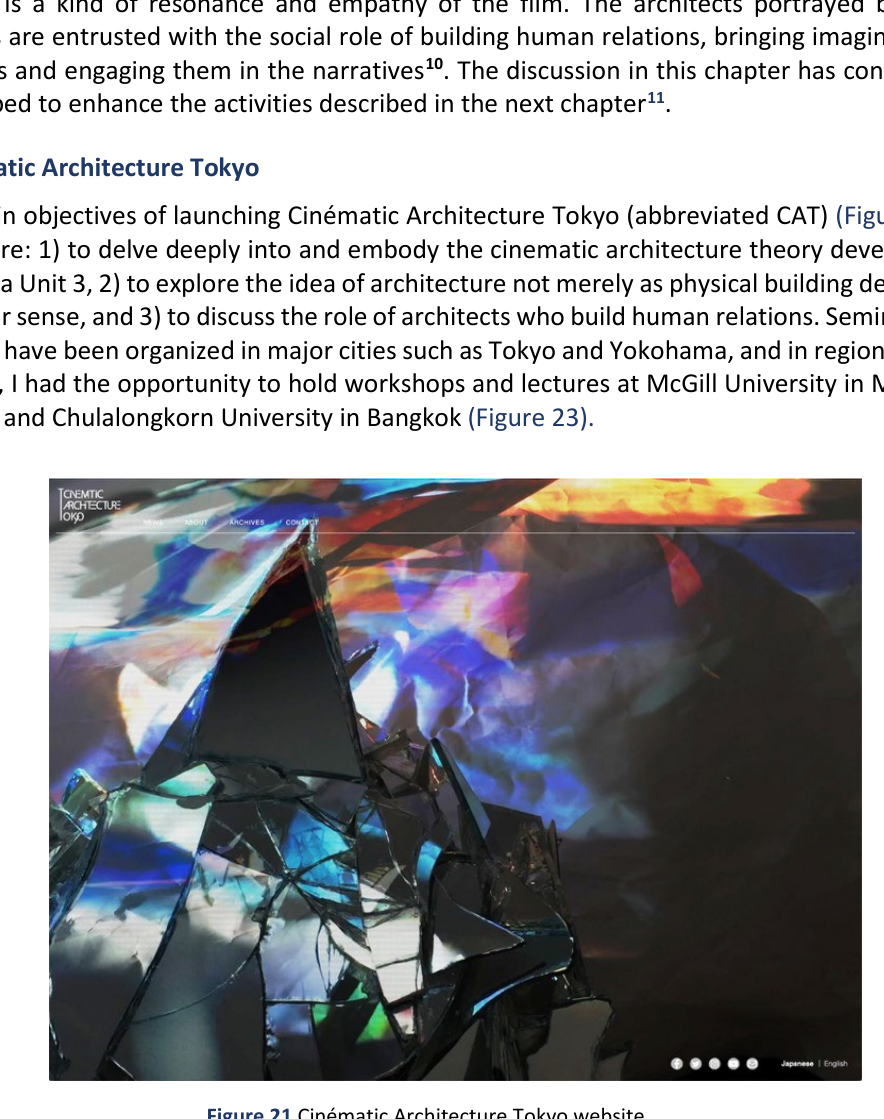
Figure 21 Cinématic Architecture Tokyo